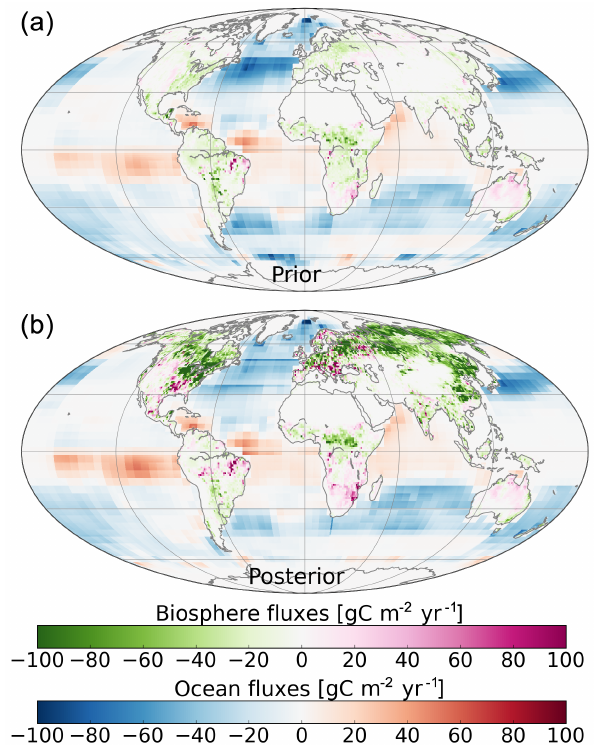
Figure 5. Global fluxes averaged over 2001–2015 for the prior es- timate (a) and posterior/optimized estimates (b) . Ocean and bio- sphere fluxes are shown on different color scales in gCm − 2 yr − 1 . Biosphere fluxes include imposed biomass burning emissions.